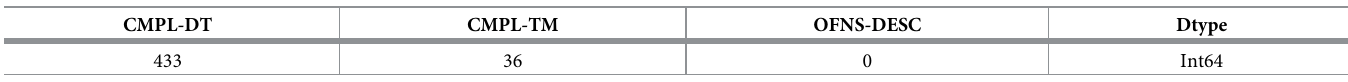
Table 2. Depiction of NULL value in the